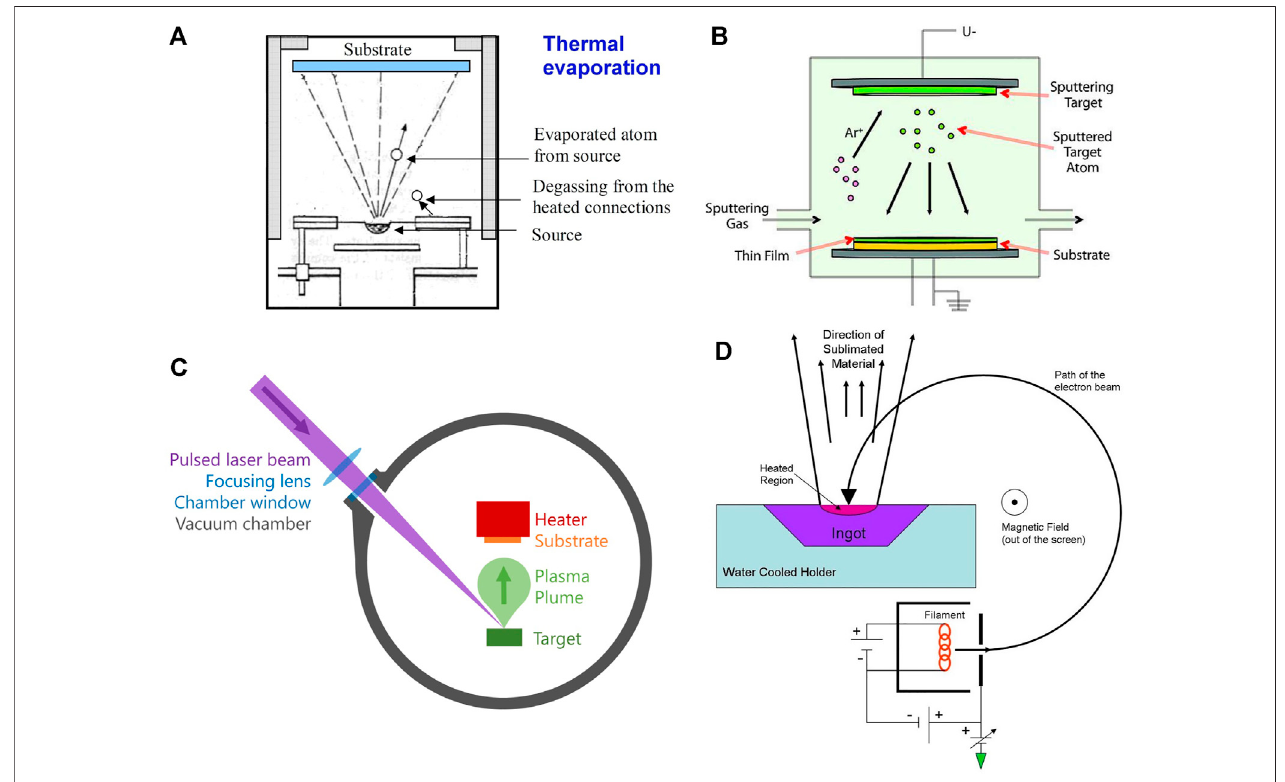
FIGURE 2 | Various physical vapor deposition techniques. (A) Thermal evaporation, S. Babar, CC BY-SA 3.0, via Wikimedia Commons, (B) sputter deposition using Ar gas, Sigma-Aldrich, CC BY-SA 4.0, via Wikimedia Commons, (C) pulsed laser deposition, (D) electron beam evaporation, Jatosado, CC BY-SA 3.0, via Wikimedia